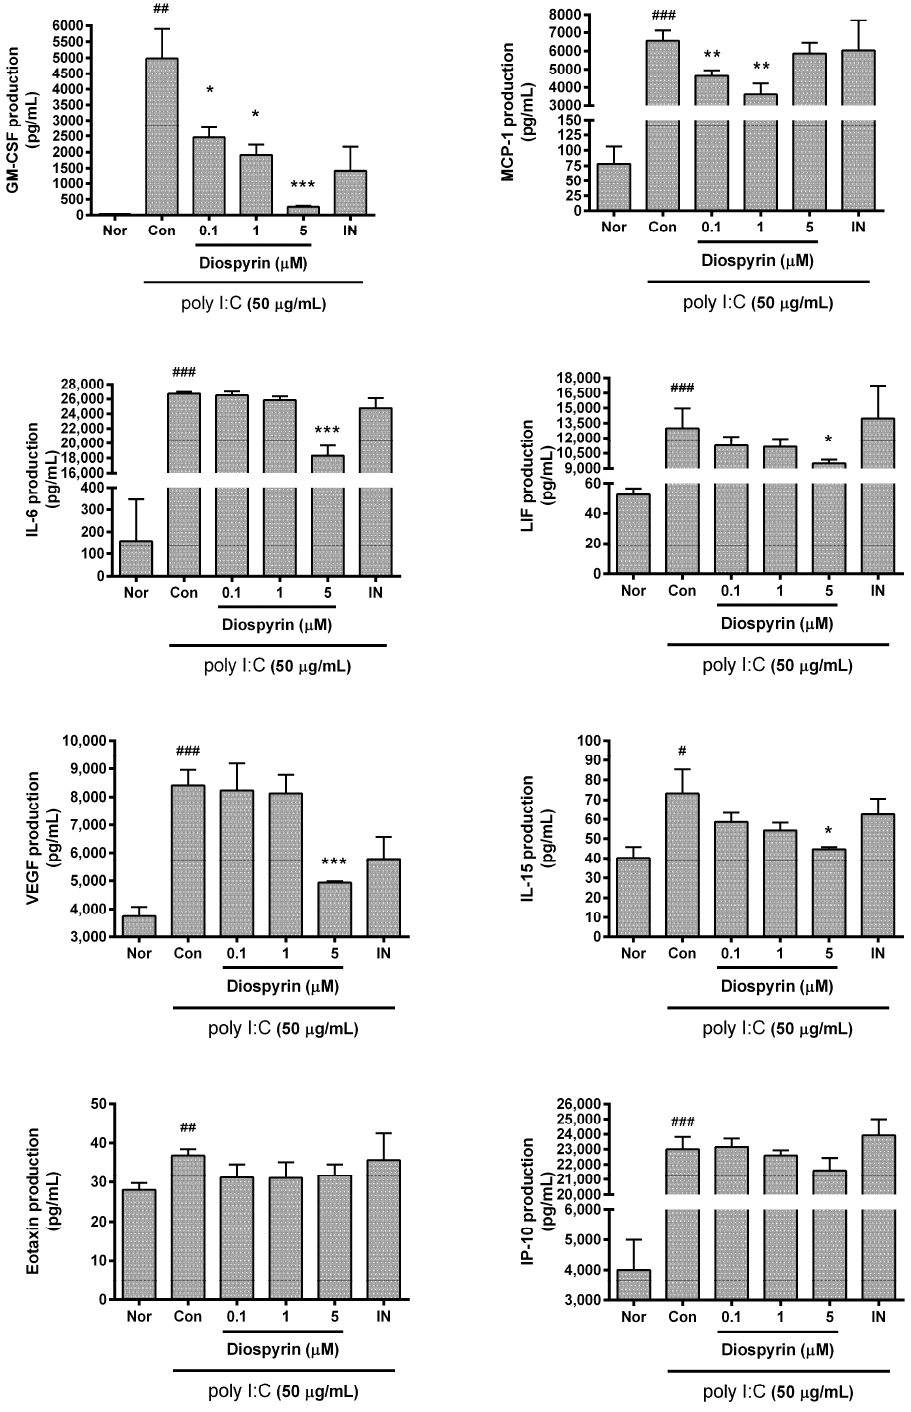
Figure 3. Effect of diospyrin on cytokine production from RAW 264.7. Values are the mean ± SD of the three independent experiments. Nor, media alone; IN, indomethacin (0.5 µ M). # p < 0.05 vs. Nor; ## p < 0.01 vs. Nor; ### p < 0.001 vs. Nor; * p < 0.05 vs. Con; ** p < 0.01 vs. Con; *** p < 0.001 vs. Con.